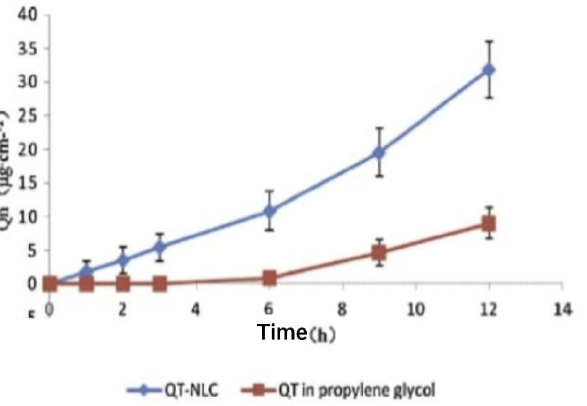
Figure 11. Profiles of QT permeation through excised rat skins from QT propylene glycol solution and QT-NLCs [50].